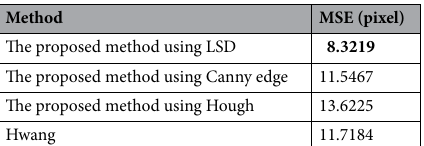
Table 4. Effect comparison of different methods. Significant values are in bold.